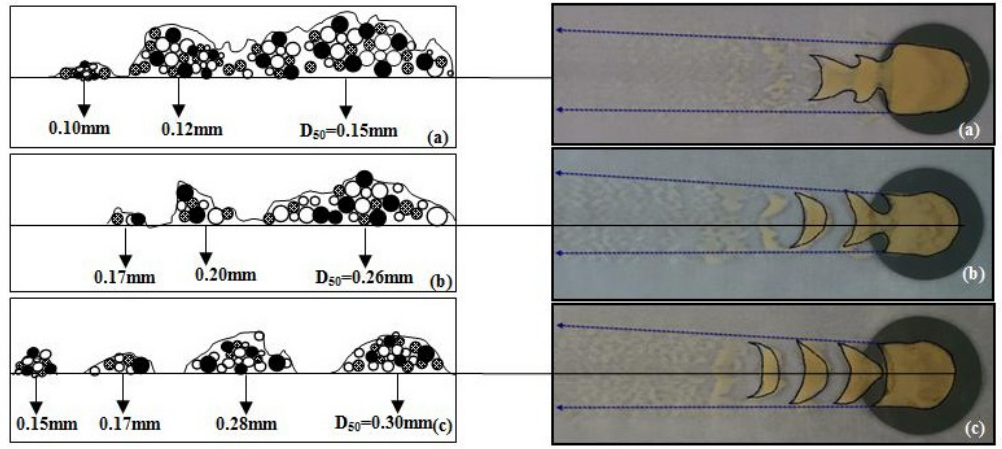
Figure 7: (a) Fixed packing equilibrium settlement of the sample d 50 =0.15mm, (b) Fixed packing equilibrium settlement of the sample d 50 =0.26 mm, (c) Fixed packing equilibrium.